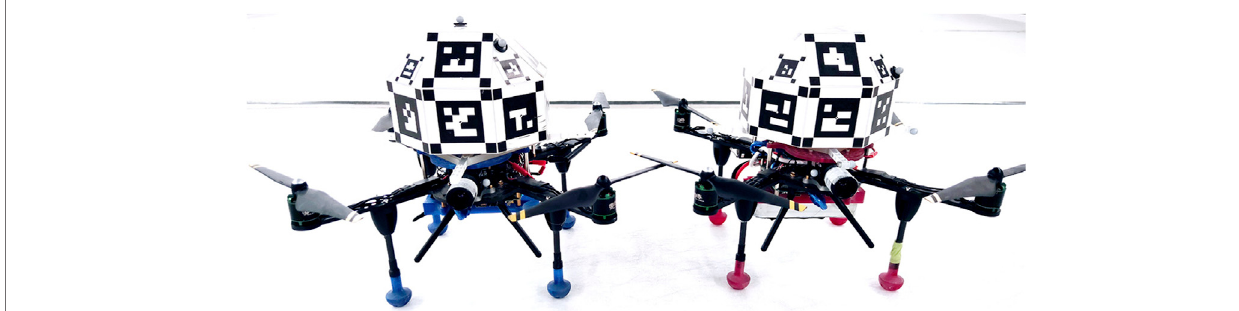
FIGURE 1 | Developed drone-con fi guration for pose estimation evaluation.